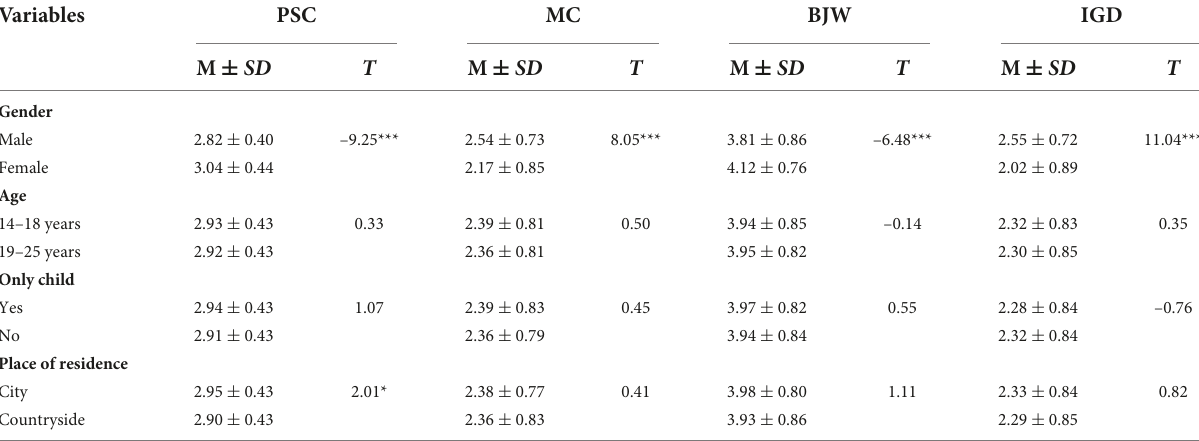
TABLE 2 Comparison of study variables on sociodemographic characteristics.